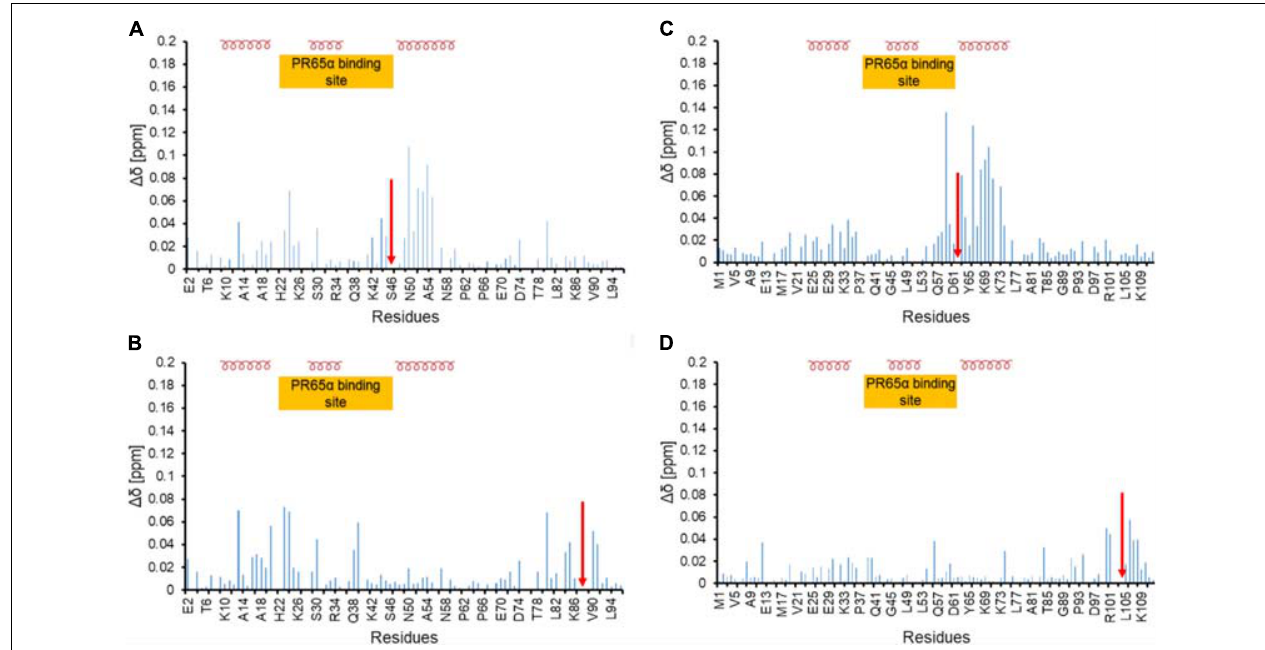
FIGURE 6 | Chemical shift perturbation of phosphomimetic mutants of ARPP-16 and ARPP19 (A) and (B) Chemical shift perturbation due to S46E and S88E mutations, respectively. (C,D) Chemical shift perturbation due to S62E and S104E mutations, respectively. (cid:49) δ [ppm] refers to the combined HN and N chemical shift changes, according to the equation: (cid:49) δ (HN, N) = sqrt[( (cid:49) δ HN) 2 + 0.2( (cid:49) δ N) 2 ]. Red arrow indicates the phosphomimetic mutation site. Positions of α -helices and the A-subunit (PR65) binding site are shown.